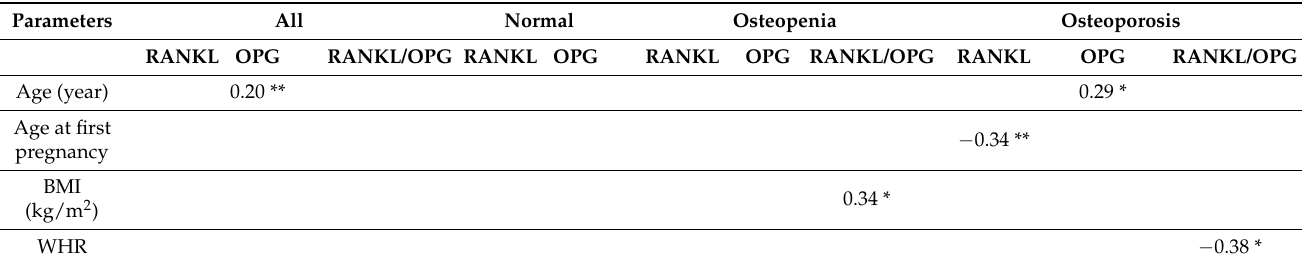
Table 2. Significant correlations of RANKL, OPG, and RANKL/OPG ratio with other parame- ters